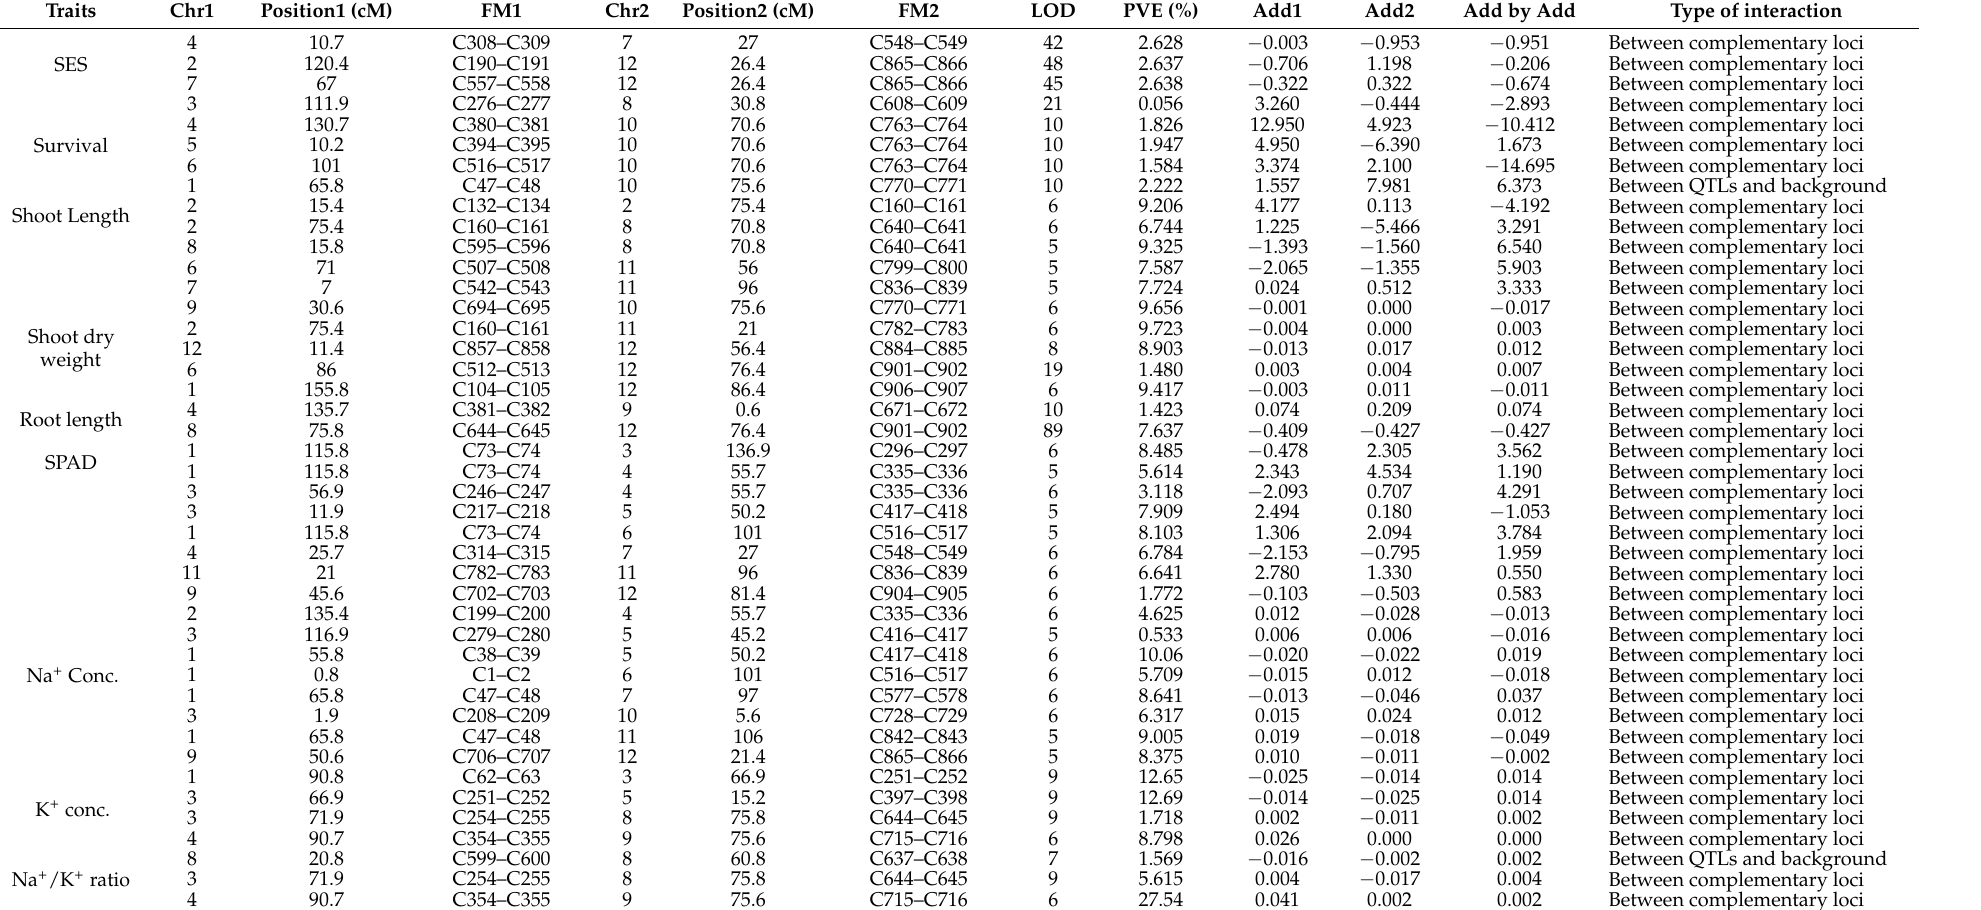
Table 4. Epistatic interaction describes how epistatic QTL interactions can affect the traits related to salinity tolerance at the seedling